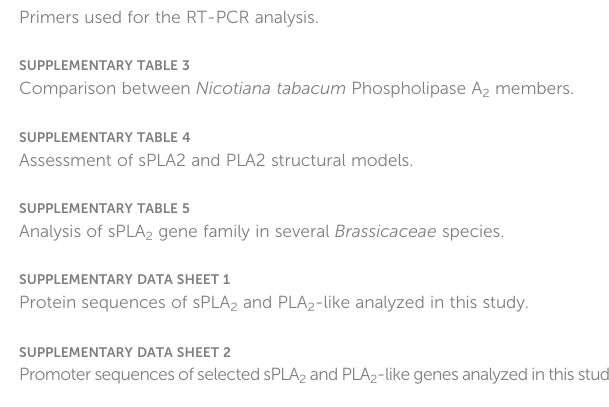
SUPPLEMENTARY TABLE 1 List of identi fi ed secretory PLA2- a , b , and PLA2-like sequences with their protein length and chromosome locations. (ND – No data, AA – Amino acids). SUPPLEMENTARY TABLE 2 Primers used for the RT-PCR analysis. SUPPLEMENTARY TABLE 3 Comparison between Nicotiana tabacum Phospholipase A 2 members. SUPPLEMENTARY TABLE 4 Assessment of sPLA2 and PLA2 structural models. SUPPLEMENTARY TABLE 5 Analysis of sPLA 2 gene family in several Brassicaceae